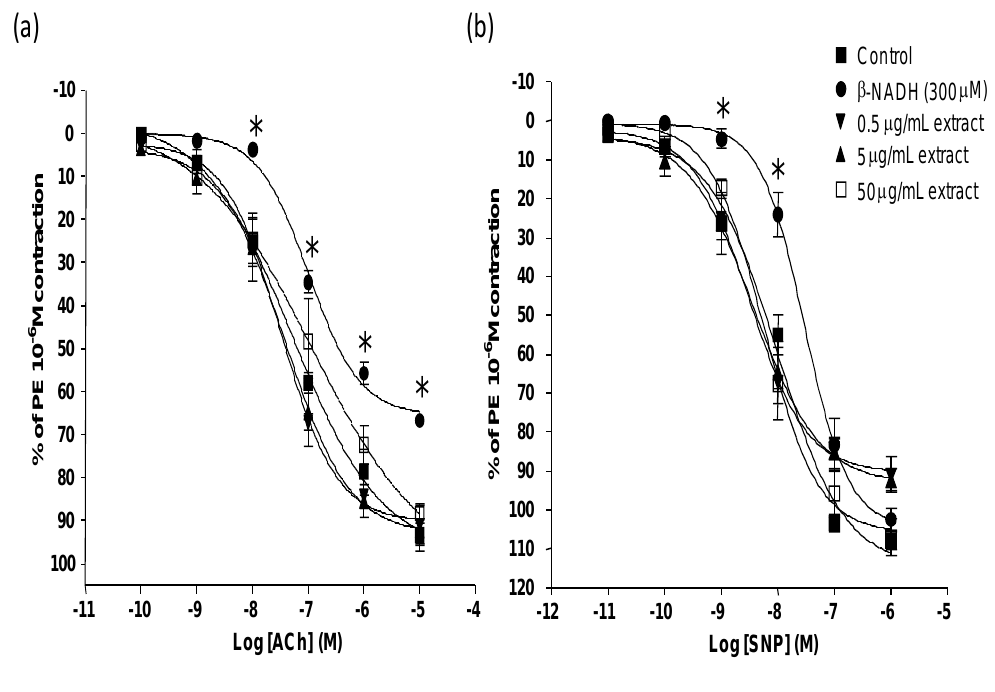
Figure 2. Effect of 0.5 μ g/mL, 5 μ g/mL and 50 μ g/mL P.grandis (stem bark) methanolic extract on (a) ACh and (b) SNP relaxation in rat aortic rings induced oxidative stress by β - NADH. Results are mean ± S.E.M (n = 5–6). Significant difference from control is indicated by * (p <